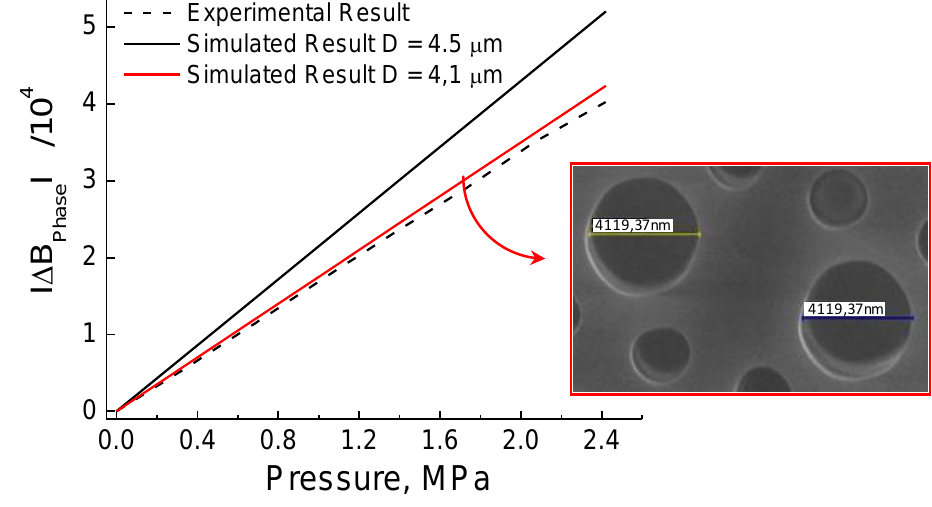
Figure 8. Change of modal birefringence with pressure at λ = 1,550 nm (numerical and experimental). The inset shows a microphotography of the commercial HiBi PCF used to assemble the pressure